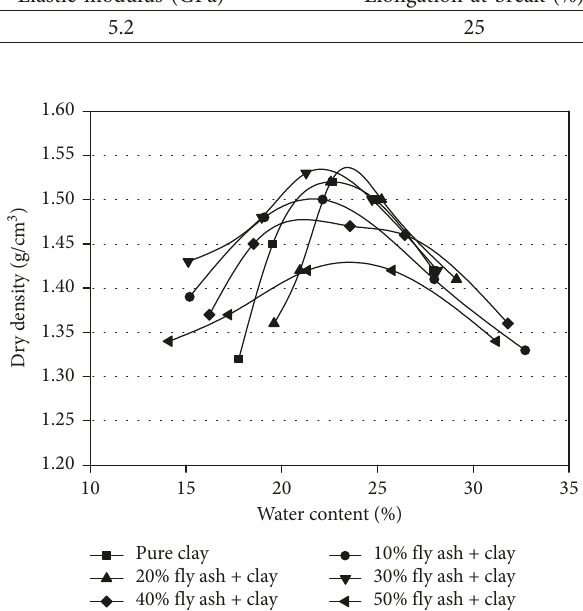
Figure 2: Standard compaction curves of fly ash-soil mixtures.